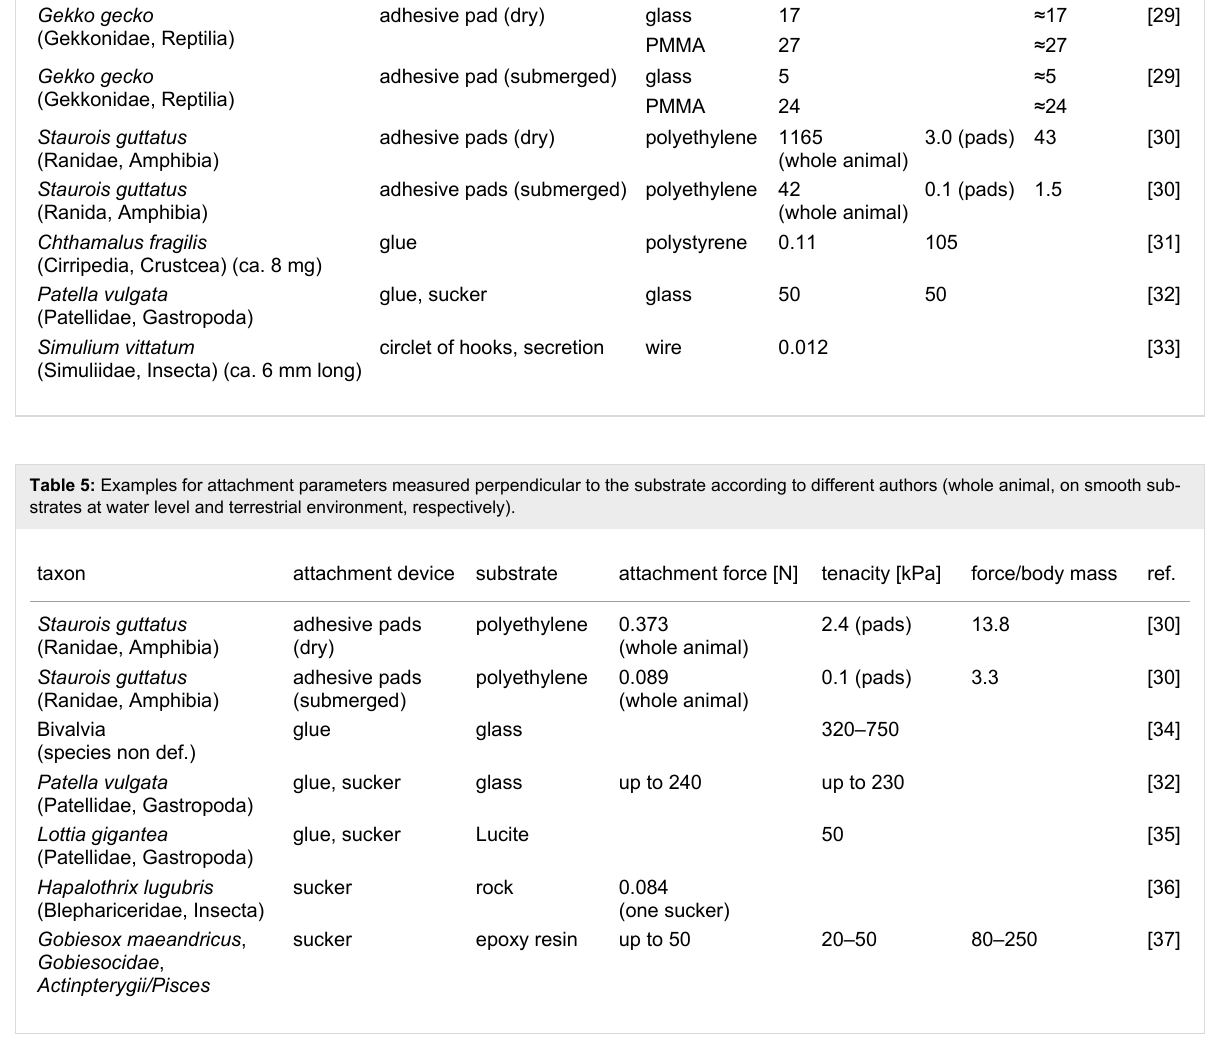
Table 4: Examples for attachment parameters measured parallel to the substrate according to different authors (whole animal, on smooth substrates at water level and terrestrial environment, respectively). taxon